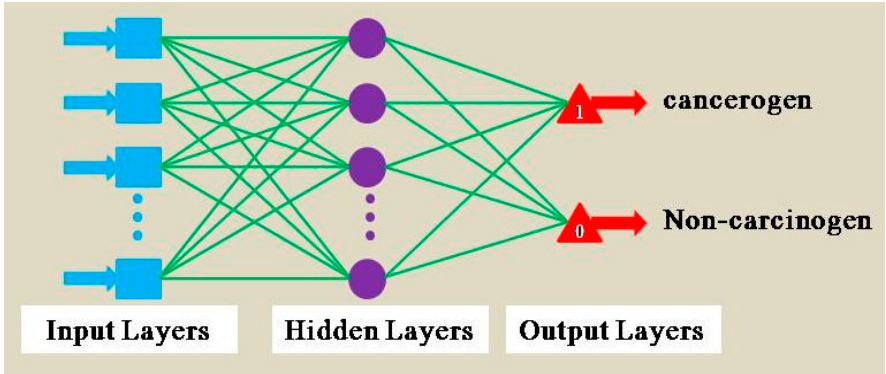
Figure 3. Multilayer perceptrons artificial neural network structure.